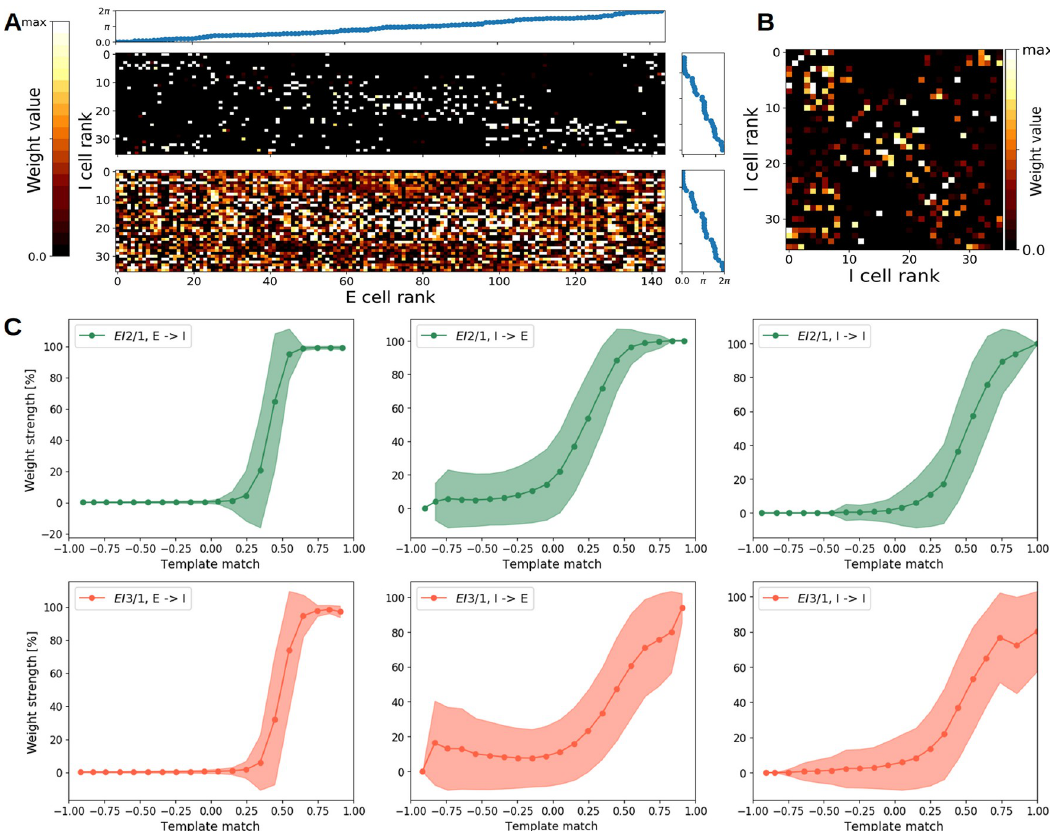
Fig 4. Synaptic connections reflect tuning similarity. Weight matrices from the excitatory to the inhibitory population (and vice versa) A , sorted by the receptive field orientation, and for the lateral inhibitory weights B . A , Top: Weights from the excitatory to the inhibitory population. A , Bottom: Weights from the inhibitory to the excitatory population. For display, all weight matrices were normalized by the maximum value. All weights are from the EI 2/1 model. C Normalized synaptic strength as a function of the template match between the pre- and postsynaptic neuron’s receptive fields for the EI 2/1 (first row) and the EI 3/1 (second row) model. Shaded areas denote the mean +/- standard deviation. As expected, we observed strong weights between neurons with highly similar receptive fields, and near-zero weights between neurons with highly dissimilar receptive fields. For neurons with a moderate degree of RF similarity, we observed a steep transition from weak to strong weights at the E-I projection. At the I-E and I-I projections, this transition was more